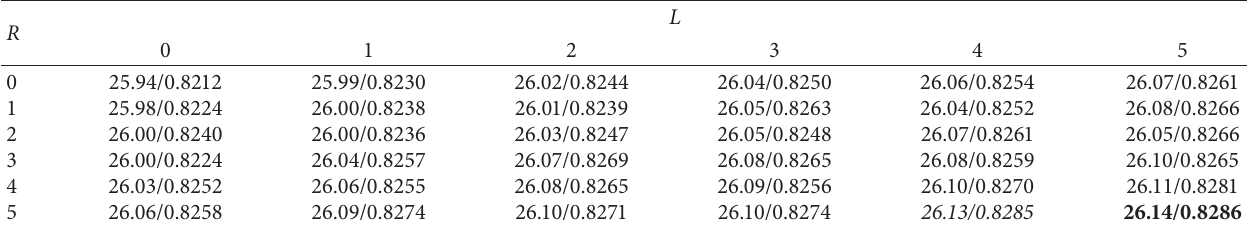
Table 4: The performances (PSNR/SSIM) under different G and T on smartphone-based City100 database ( L � 4 and R � 5 fixed). G